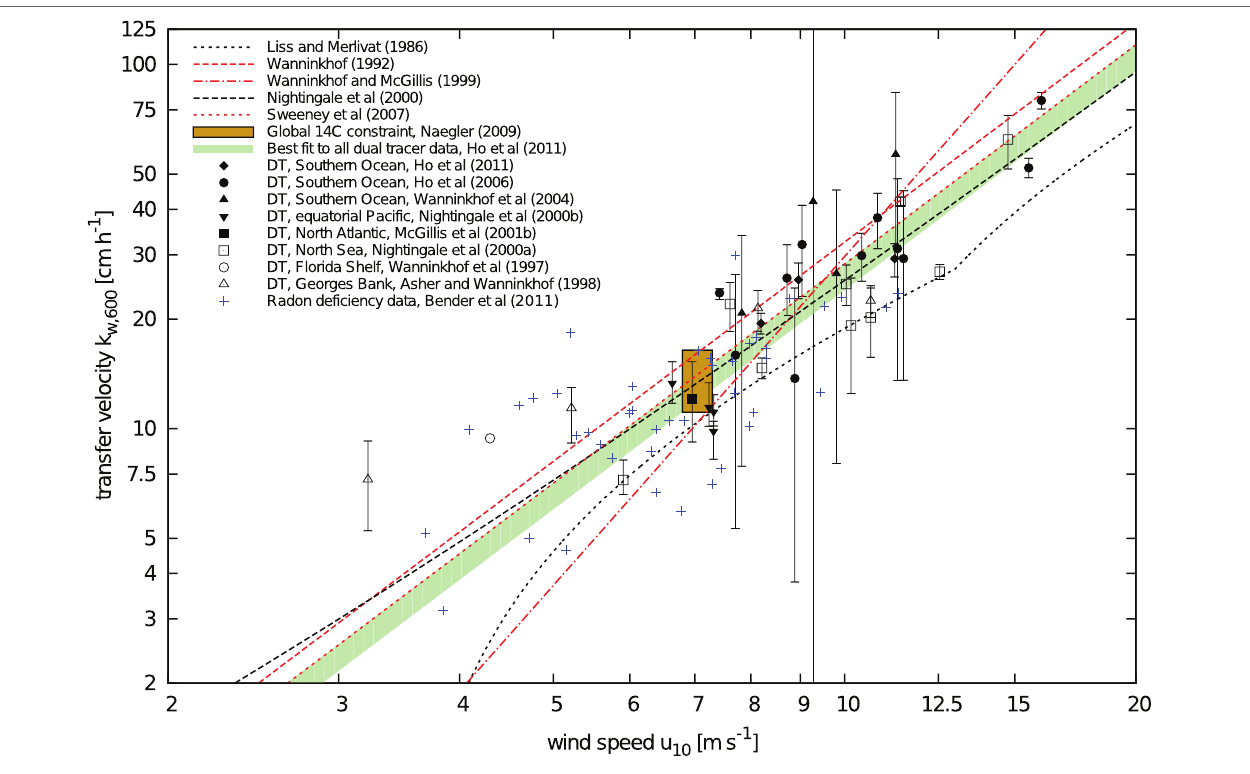
FigURe 2 | Gas transfer velocity as a function of the wind speed from many recent gas transfer field experiments including the dual tracer technique (DT), see Watson et al. (1991) and Wanninkhof et al. (1993), the radon deficit technique (Bender et al., 2011), and the global 14 C constraint (Naegler, 2009) together with some of the empirical gas transfer velocity/wind speed relations as indicated. Drawn in logarithmic scales on both axes after Garbe et al. (2014) (Wanninkhof and McGillis, 1999; Nightingale et al., 2000; Sweeney et al.,